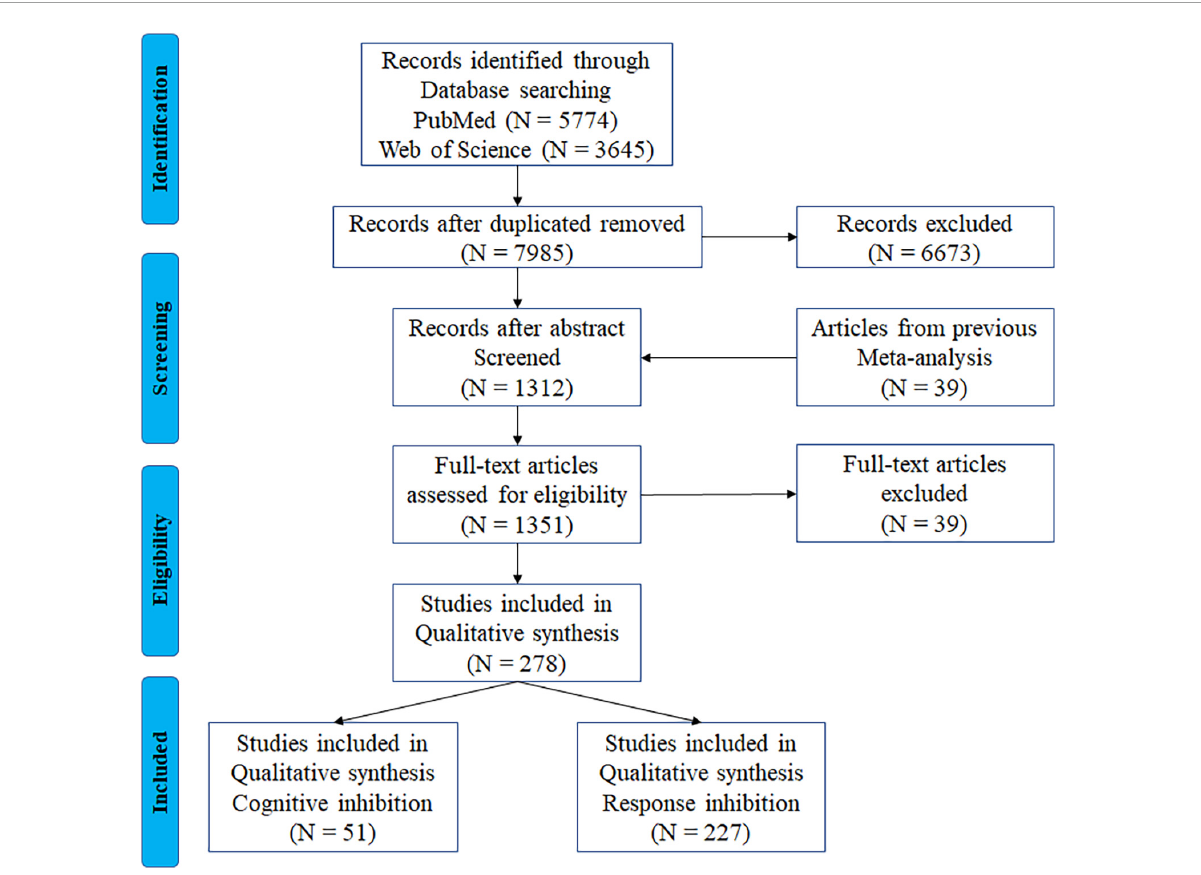
FIGURE1 PRISMA flowchart for the identification and eligibility of articles. N = number of